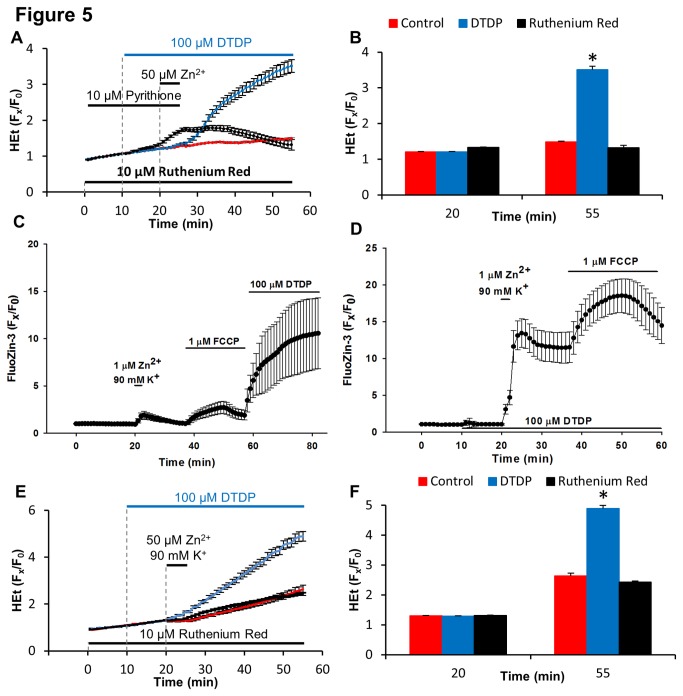
Under conditions of oxidative stress and disrupted Zn2+ buffering, lower levels of Zn2+ influx result in mitochondrial Zn2+ entry and ROS production.
A: Effect of DTDP on Zn2+-triggered ROS generation. HEt-loaded cultures were exposed to 50 μM Zn2+/pyrithione alone (red), in the presence of DTDP (100 µM, blue), or with both DTDP and RR (10 µM, black) as indicated. Note that the Zn2+/pyrithione exposure only induced ROS generation in the presence of DTDP, and that the ROS production was eliminated by RR. Traces show mean ± SD values from 4 experiments.
B: Quantification of HEt fluorescence changes. Values show HEt fluorescence changes (Fx/F0) at the times indicated on the traces shown in A. Values represent means (± SEM) of the 4 experiments; * indicates difference from control condition (p< 0.01) by 2-tailed t test.
C, D: Disruption of cytosolic Zn2+ buffering by DTDP markedly increases cytosolic Zn2+ rises and uptake into mitochondria. Fluo-Zin3-loaded cultures were exposed to 1 μM Zn2+ with 90 mM K+ (“Zn2+/high-K+”, to trigger a low level of Zn2+ influx), to FCCP (1 µM), or to DTDP (100 µM) as indicated. In C, when the cultures were first exposed to Zn2+/high-K+ there was a very small FluoZin-3 ∆F, and subsequent FCCP exposure, to depolarize the mitochondria and release mitochondrially-sequestered Zn2+ into the cytosol, caused only a slight further increase. However, adding DTDP after the FCCP produced a large FluoZin-3 ∆F, suggesting that the Zn2+ entering during the Zn2+/high-K+ exposure had been largely buffered in the cytosol with little entering the mitochondria. In contrast (D), when the cultures were first exposed to DTDP (100 µM), there was a minimal FluoZin-3 ∆F, but when the DTDP exposure was followed by Zn2+/high-K+, the cytosolic ∆F was dramatically increased, and subsequent FCCP exposure resulted in a marked further ∆F, indicative of Zn2+ having accumulated within the mitochondria. Traces show mean ± SD values from 120 neurons from 4 experiments.
E: 50 μM Zn2+/high-K+ exposure cause mitochondrial ROS production only in the presence of DTDP. HEt-loaded cultures were exposed to 50 μM Zn2+/90 mM K+ alone (red) or after pre-treatment with and in the presence of DTDP alone (100 µM, blue) or with RR (10 µM, black) as indicated. Traces represent time course of HEt ∆F, normalized to baseline values (Fx/F0) and show mean ± SD values from 4 experiments.
F: Quantification of HEt fluorescence changes. Values show HEt fluorescence changes (Fx/F0) at the times indicated on the traces shown in E. Values represent means (± SEM) of the 4 experiments; * indicates difference from control condition (p< 0.01) by 2-tailed t test.